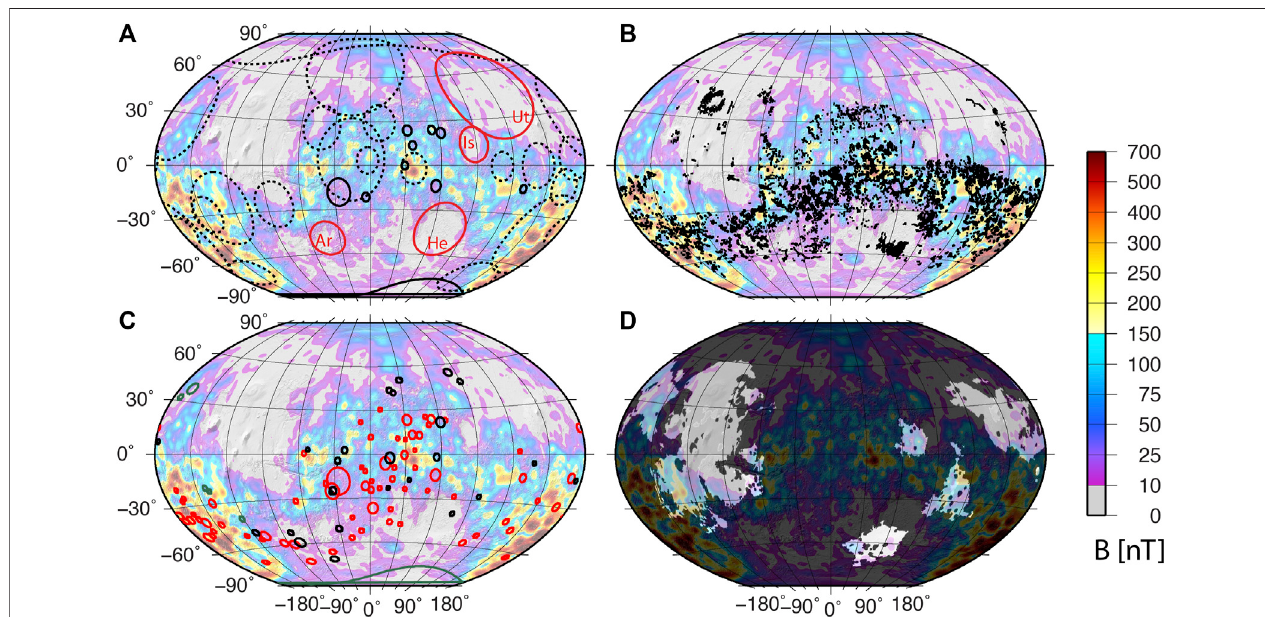
FIGURE4| Theamplitude|B|ofthecrustalmagnetic fi eldasshownin Figure1 overlainby (A) largeimpactbasinsfromRobbinsetal.(2013)(solidblack) andFrey (2008) (dashed black) and the basins Hellas (He), Utopia (Ut), Isidis (Is) and Argyre (Ar) highlighted in red (B) the valley network (Hynek et al., 2010) (C) craters larger than 150 km(RobbinsandHynek,2012)color-codedbyunderlyinglayerage(Tanakaetal.,2014)(Pre-)Noachian=red,Hesperian=black,Amazonian=green (D) highlights volcanic areas as de fi ned by Tanaka et al. (2014)